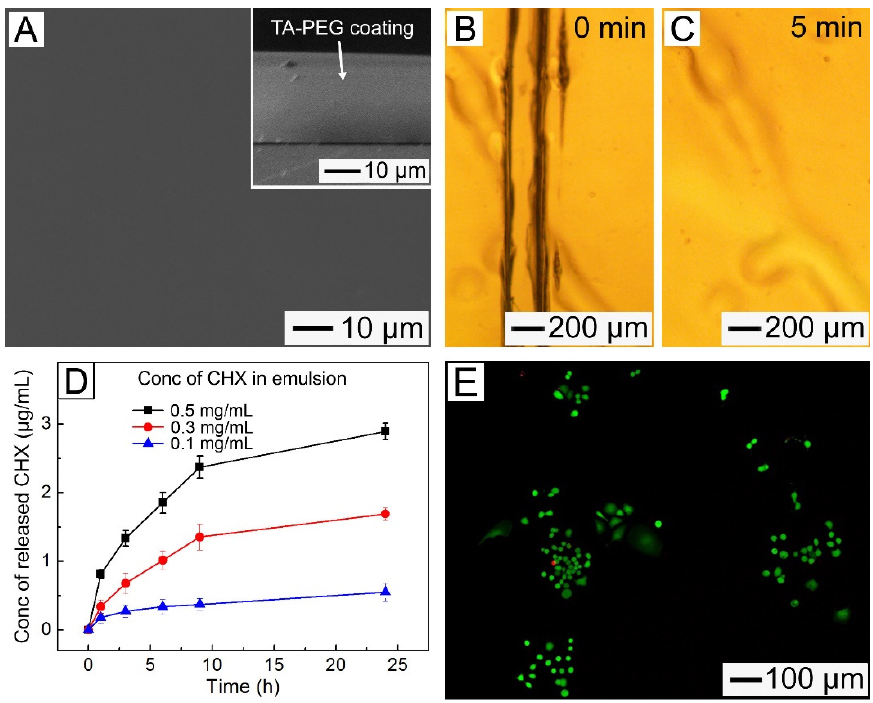
Figure 6. ( A ) SEM image of the PMMA substrate coated with the CHX-loaded TA–PEG coating layer containing 5 mg/mL TA, 5 mg/mL PEG (with M W = 100 kDa), 2 M NaCl and 0.1 mg/mL CHX for 10 min. The inset shows a cross-sectional SEM image of the substrate. ( B , C ) Optical micrographs of the CHX-loaded TA–PEG coating layer with a cut on its surface: ( B ) before and ( C ) after exposure to water for 5 min. ( D ) Release profiles of CHX from the TA–PEG coating layers prepared using the emulsions with different concentrations of the drug. ( E ) Confocal laser scanning (CLS) micrograph showing live (green) and dead (red) MC3T3-E1 cells on the TA–PEG layer prepared using the emulsion containing 7.5 mg/mL TA, 5 mg/mL PEG (M W = 100 kDa), and 2 M NaCl.